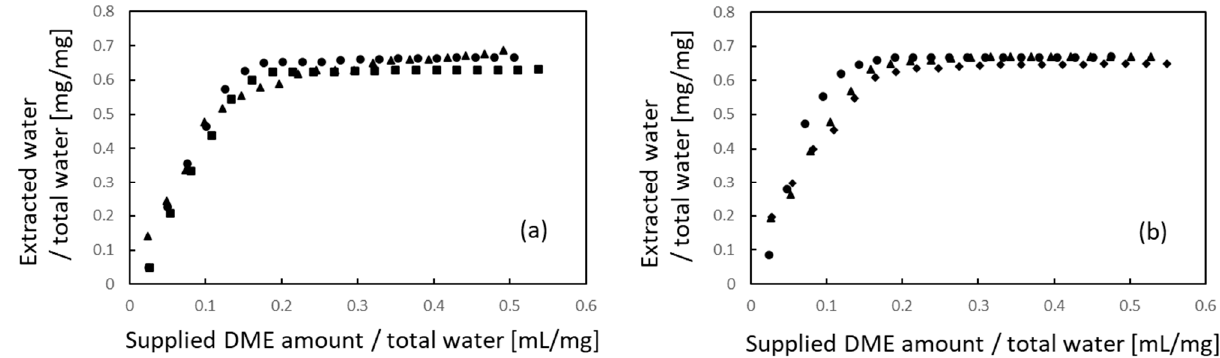
Figure 4. Water extraction from porcine auricular cartilage using liquefied DME. ( a ) 10 × 10 × 1 mm samples, ( b ) 710–1000 µ m-sized samples. The three symbols represent individual differences among three samples.